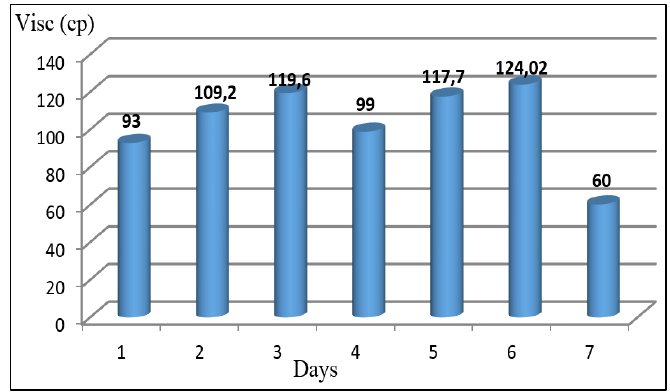
Figure 3: Viscosity behavior after 10 days of evaluation.